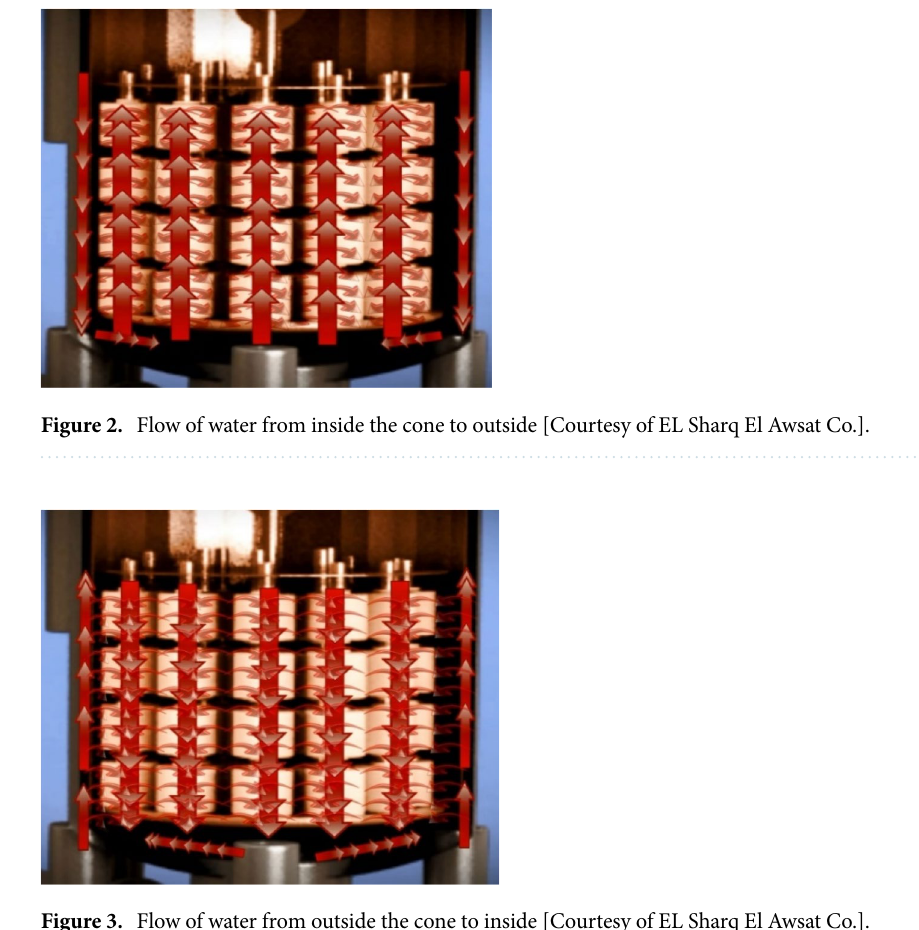
Figure 3. Flow of water from outside the cone to inside [Courtesy of EL Sharq El Awsat